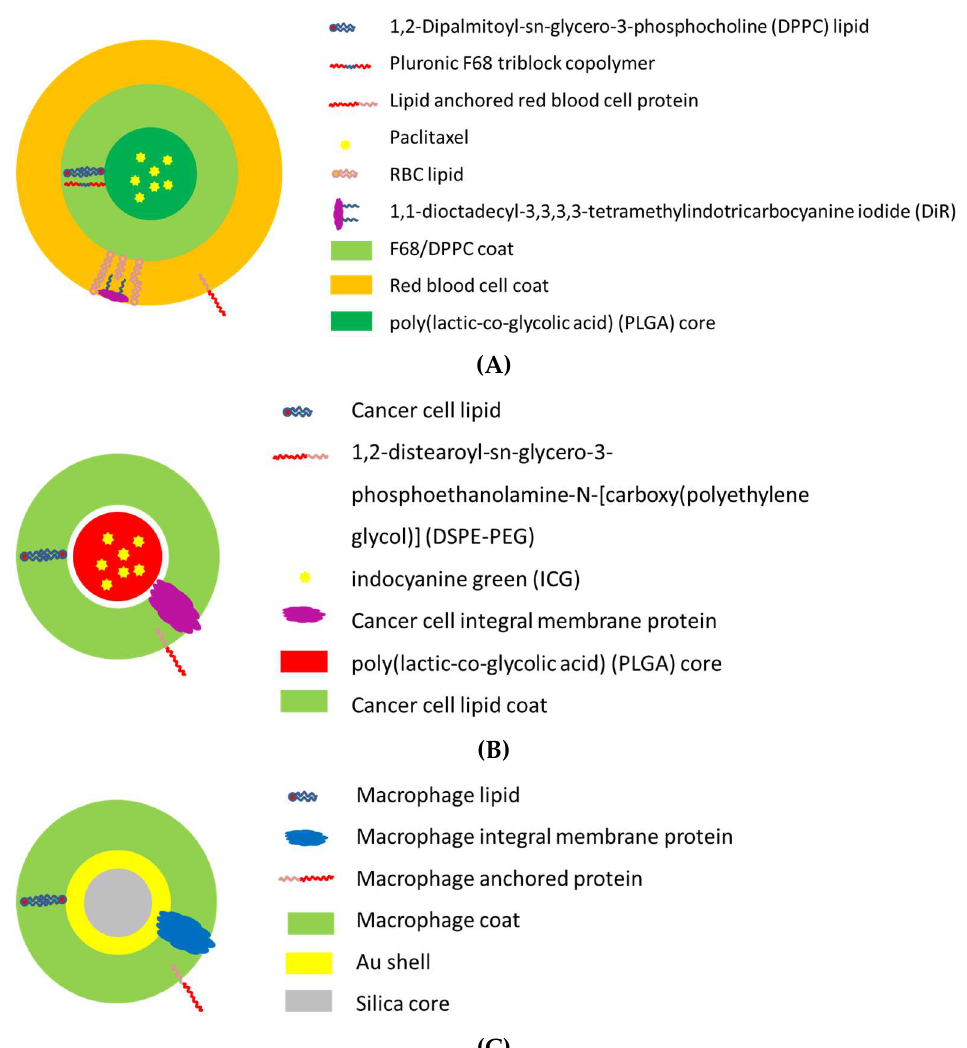
Figure 3. Examples of thermo-responsive nano-carrier designs with biomimetic membrane coatings where the basic mechanism of action is to induce a local temperature increase by near-infrared laser illumination to >43 °C which leads to hyperthermal tissue (tumor) destruction. ( A ) Red blood cell mimicking carrier for delivering paclitaxel (PTX) using 808 nm laser irradiation which is captured by the membrane embedded DiR dye molecule. The ensuing thermal energy triggers a DPPC phase transition and core destruction, resulting in the release of the chemotherapy medication PTX [89]. ( B ) Cancer cell mimicking carriers for delivering the diagnostic dye indocyanine dye. By utilizing binding molecules from cancer cell membranes adhesion to homologous cancer cells can be achieved while the DPPE-PEG prevents phagocytosis non-specific binding to serum proteins resulting in tumor accumulation of the nano-carrier. Irradiation at 780 nm results in energy absorption in ICG and thermal destruction of the tumor [90]. ( C ) Macrophage-camouflaged carrier where macrophage proteins provide molecular recognition with tumor proteins and the Au-coated silica core allows for energy absorption at 808 nm leading to thermal tumor destruction [91] .